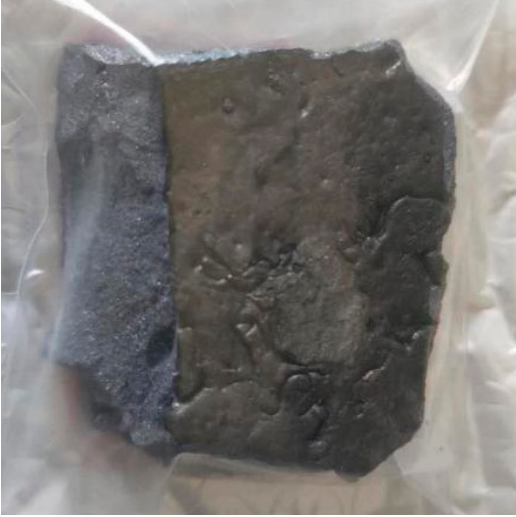
Figure 6. Mg 30 Zn 30 Sn 30 Sr 5 Bi 5 (at%) alloy block (40 mm × 40 mm × 20 mm).